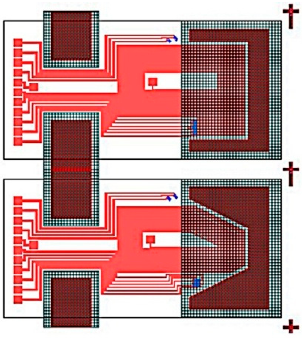
Figure 5. Two differentmicro-cantilever chips.